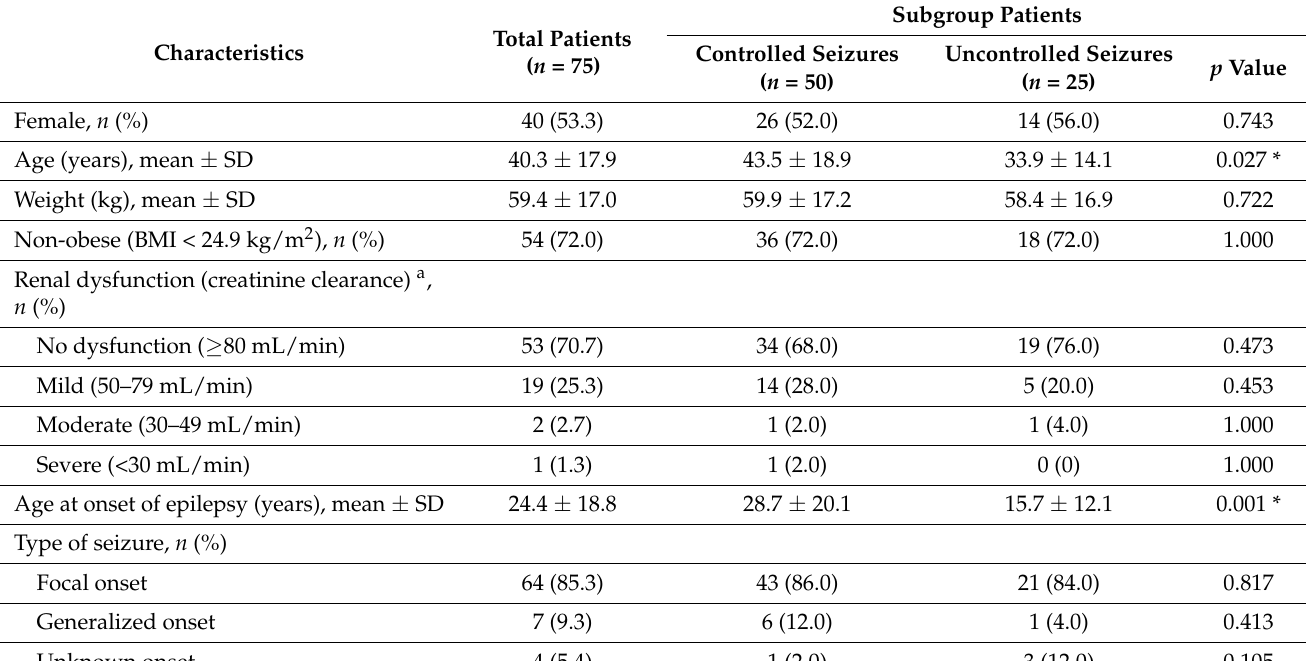
Table 1. Baseline characteristics of total patients and patient